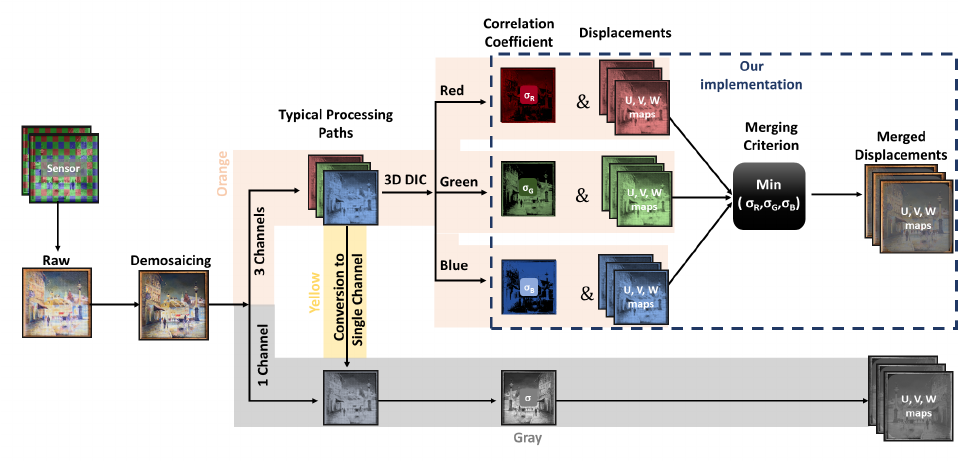
Figure 1. Schematic representation of data processing